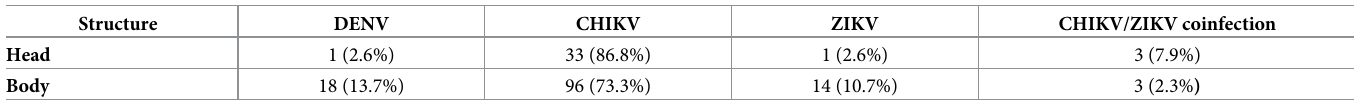
Table 2. Number of anatomical structures of Ae . aegypti mosquitoes infected with either DENV, CHIKV and/or ZIKV, collected during the ABV transmission sea- sons of 2016 and 2017 in Yucata´n, Mexico. Percentages indicate the fraction of infection with each virus for each anatomical structure. Structure